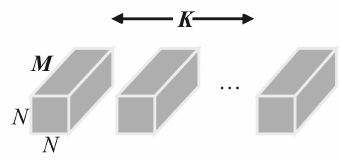
Figure 1. Standard convolution.